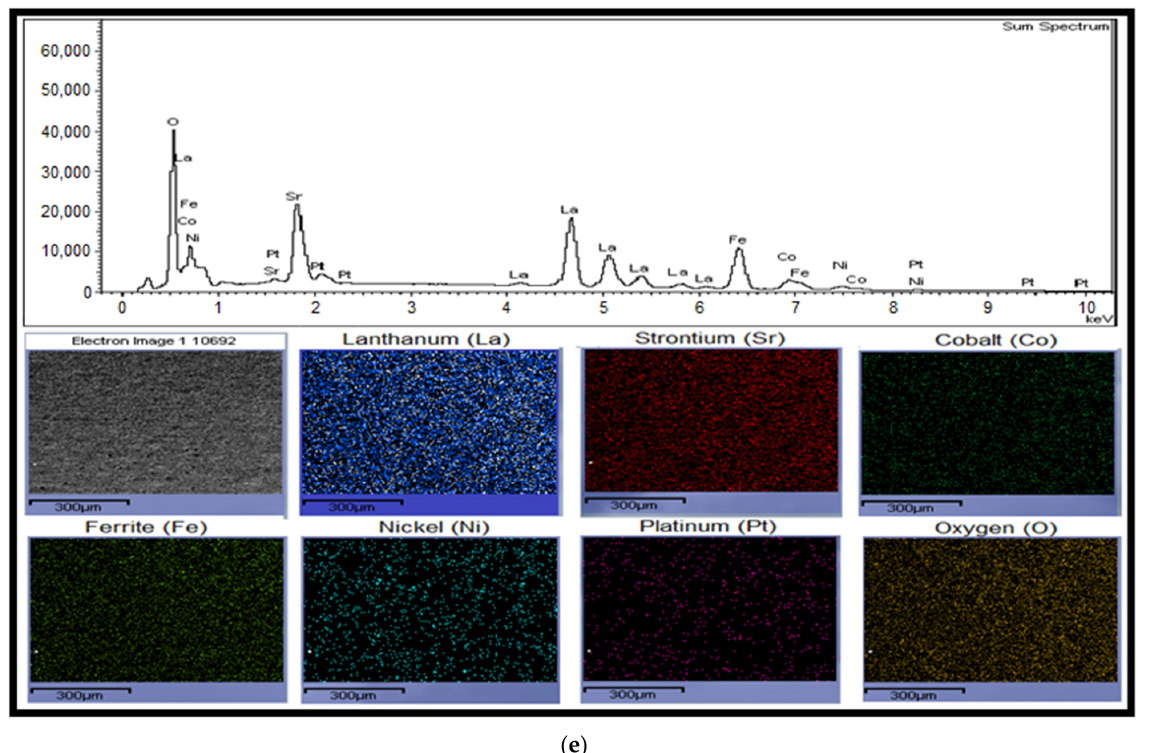
Figure 6. SEM images for the surface microstructure of ( a ) surface of bare LSCF cathode; ( b ) surface of LSCF with 5 wt% of NiO cathode; ( c ) cross-sectional image of LSCF-NiO single cell; ( d ) close-up cross-sectional image between LSCF-NiO cathode and GDC electrolyte with the presence of porosity presented in the screen-printed layers (red colour); ( e ) EDX analysis and mapping of LSCF with 5 wt% of NiO cathode surface.